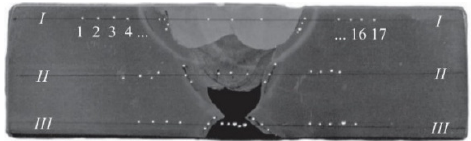
Figure 2. Cross-sections of a metallographic sample with directions and micro hardness measuring Figure2. Cross-sectionsofametallographicsamplewithdirectionsandmicrohardnessmeasuringspots.